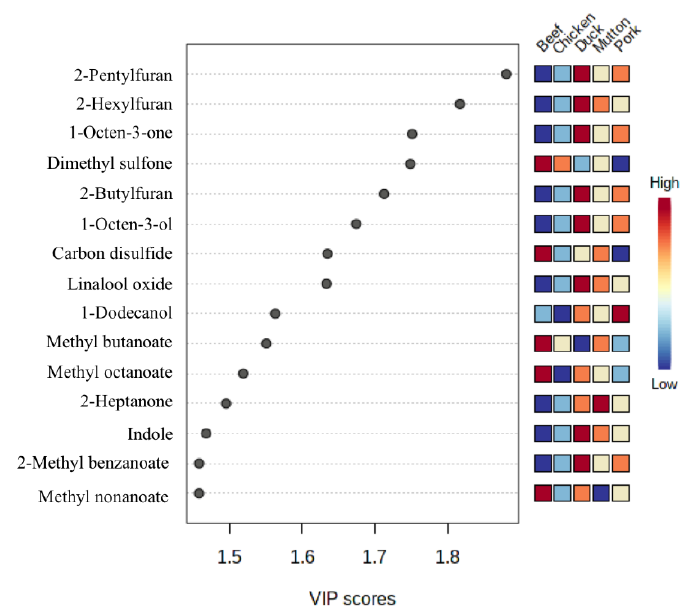
Figure 5. Variable importance in projection (VIP) score of volatile compounds.